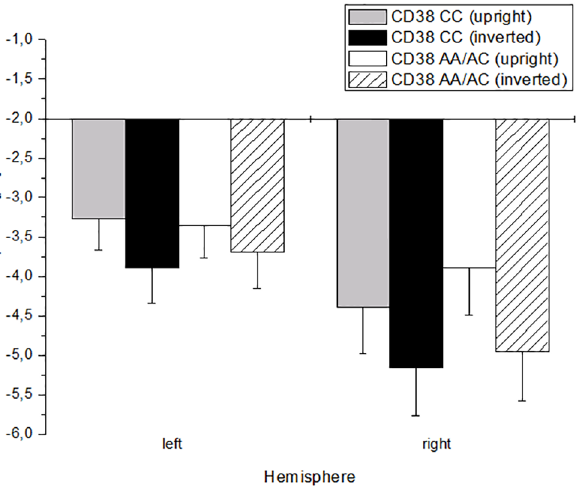
Fig 2. N170-amplitudes in reaction to upright and inverted neutral faces in dependence on allele- frequency of CD38 and hemisphere. Error bars reflect the standard error of the mean